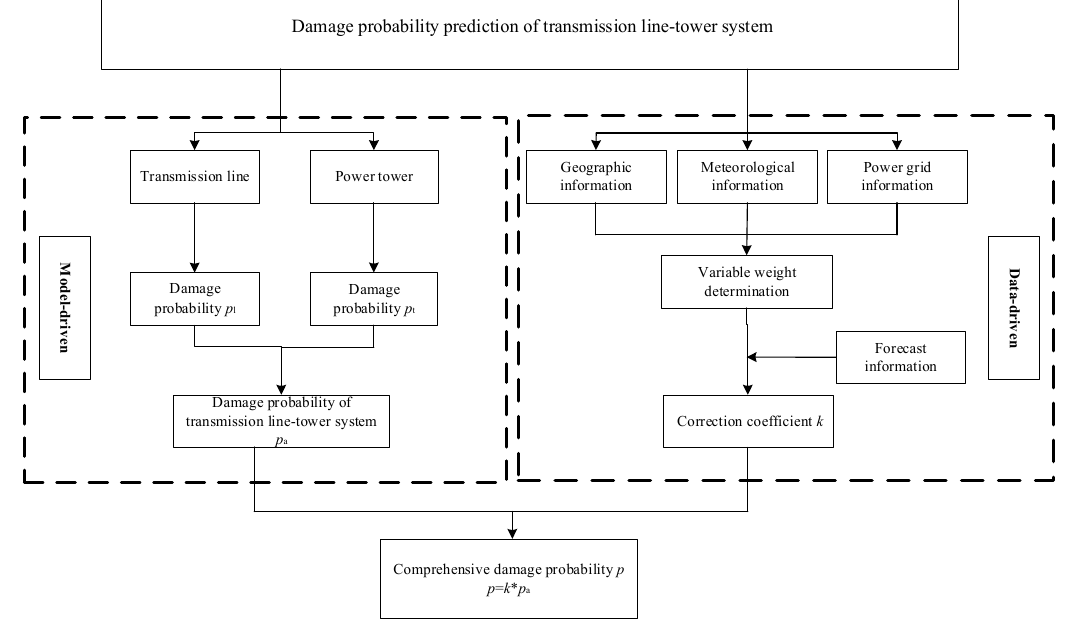
Figure 1. Damage probability prediction framework of the transmission line-tower system. 127